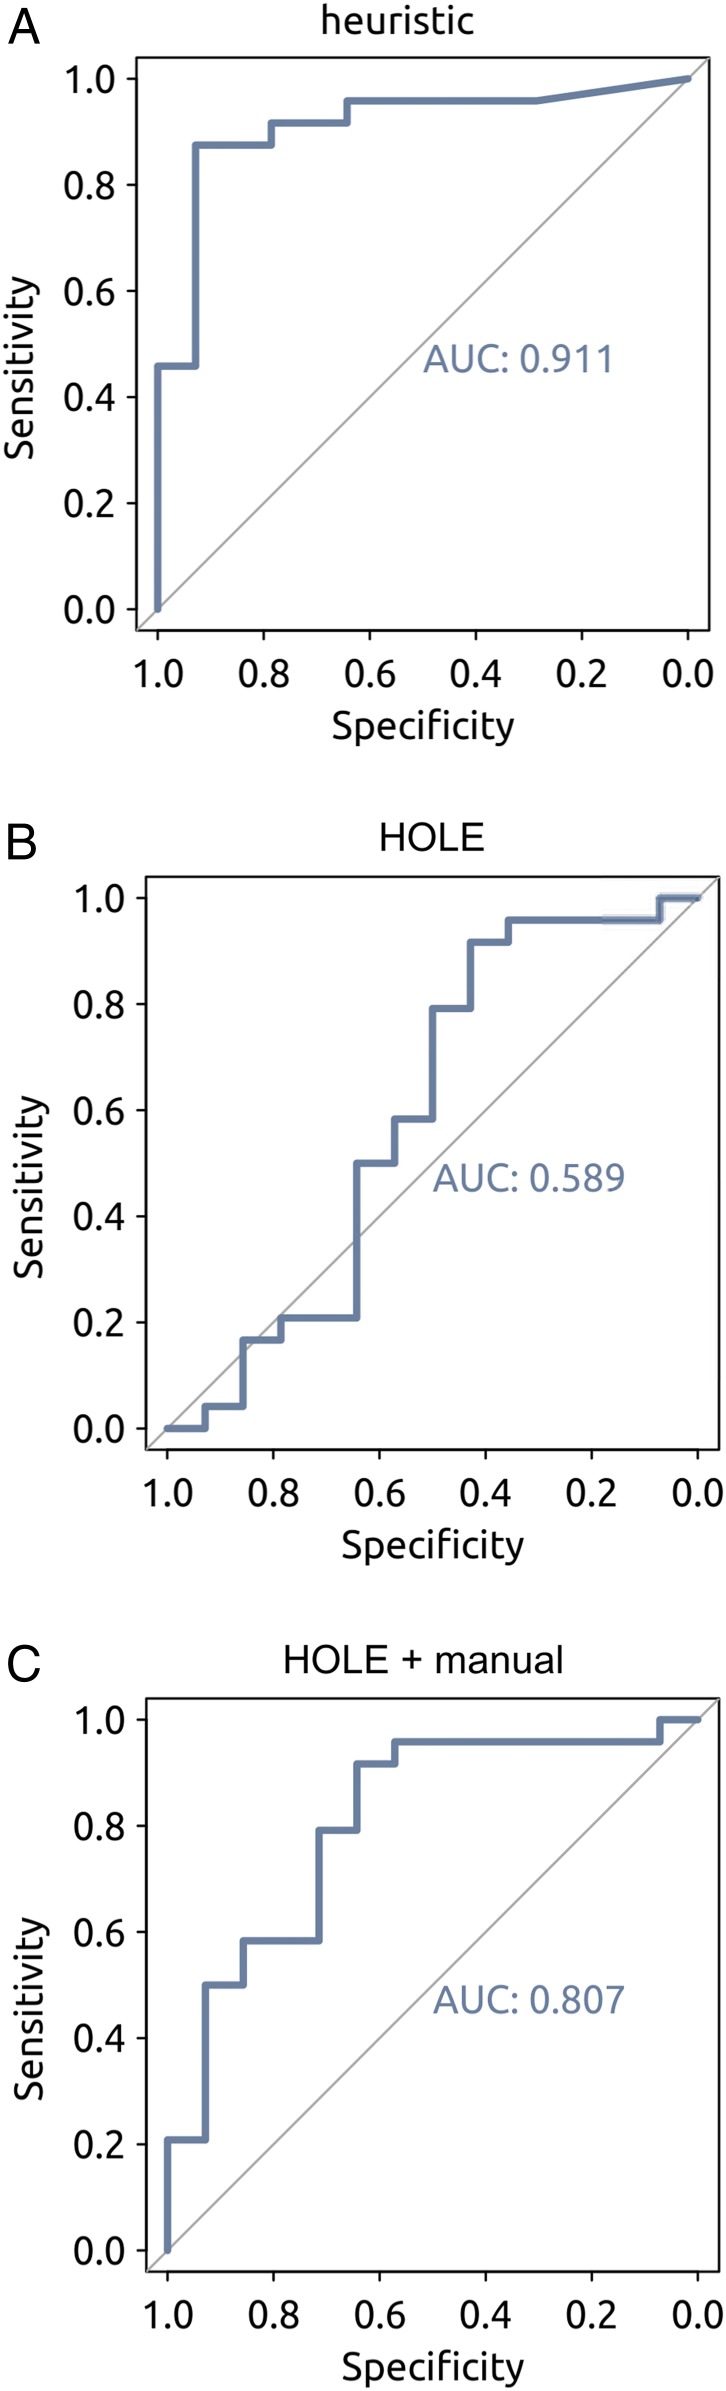
ROC curve analyses based on comparison of simulations of pore wettability (SI Appendix, Table S1) and heuristic-based predictions. The heuristic predictions are evaluated against the simulation results for pore wettability and the relationship between sensitivity (i.e., true positive rate) and specificity (i.e., true negative rate) are defined and displayed in the standard fashion. (A) ROC curve for the heuristic model presented in the current study, indicating an optimal cutoff of Σd = 0.55 for the heuristic prediction of a closed channel. (B and C) ROC curve for predictions based on HOLE (B) and ROC curve for predictions based on HOLE plus manual correction for channels with K+ channel-like selectivity filters (C). In each case, the AUC is given.